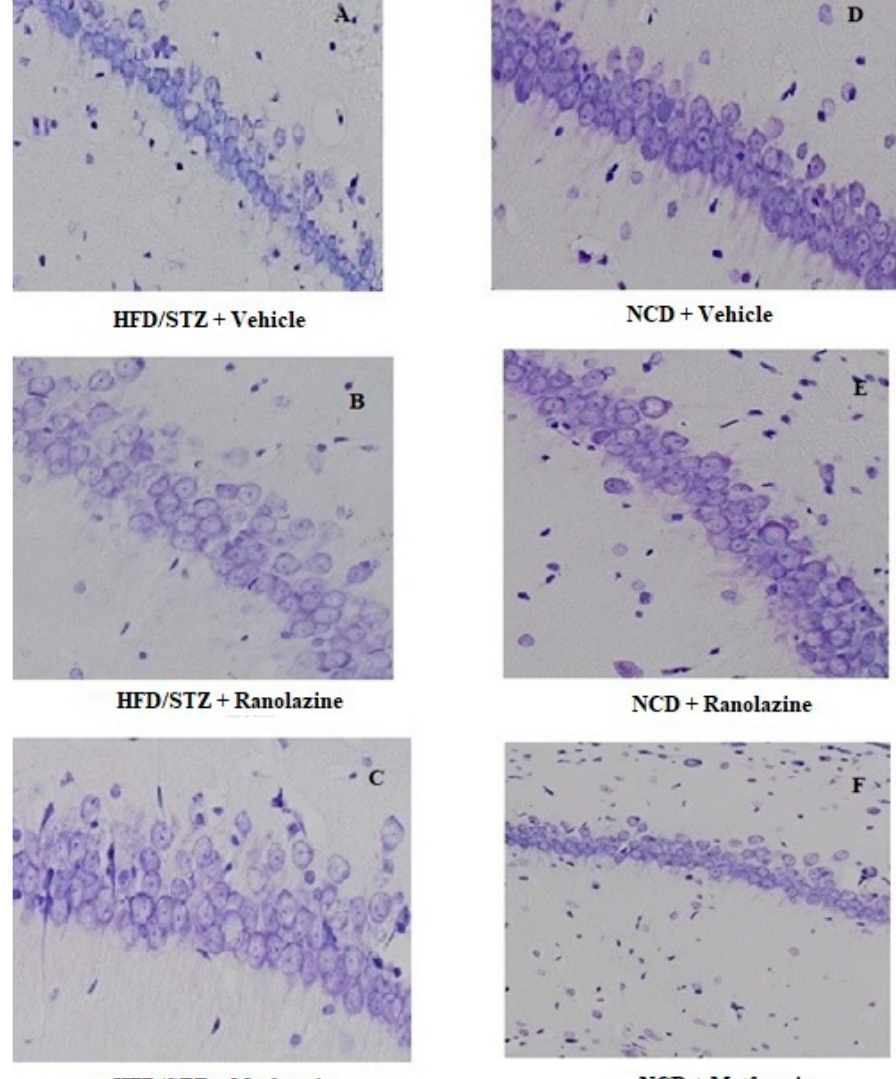
Figure 1. Representative images of histological analysis. Magnification 20x. Cresyl violet staining was performed on a section from the hippocampal CA1 region in (A) HFD/STZ + Vehicle group, (B) HFD/STZ + Ranolazine group, (C) HFD/STZ + Metformin group, (D) NCD + Vehicle group, (E) NCD + Ranolazine group, (F) NCD + Metformin group. HFD = high fat diet; NCD = normocaloric diet; STZ = streptozotocin.